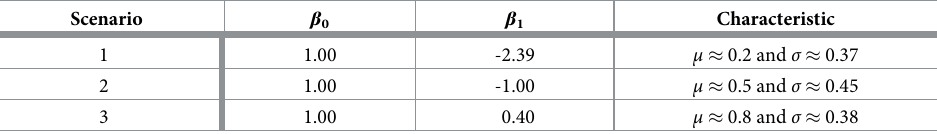
Table 2. Parameter values for scenarios considered in the simulation, when the true data-generating process is beta distributed (in-control